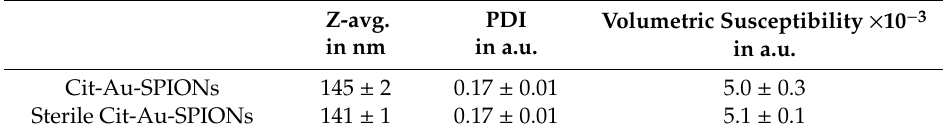
Table 5. Comparison of the Z-average and volumetric susceptibility of Cit-Au-SPIONs before and after autoclaving. Z-avg.